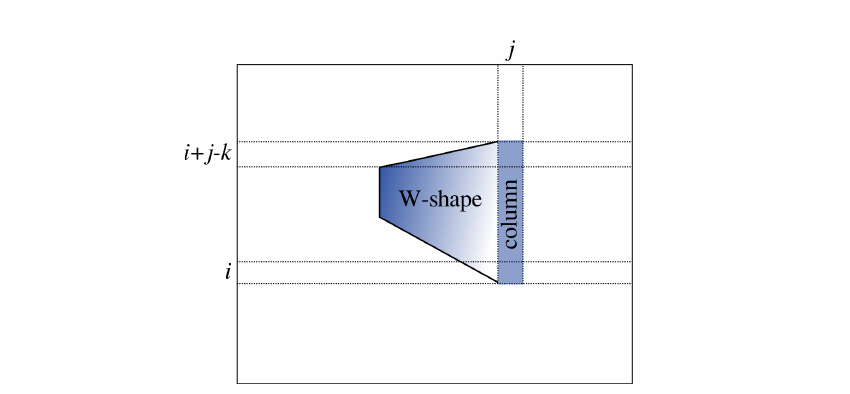
Figure 8. Illustration for Algorithm 8 with position indices ( i , j ) and time index k